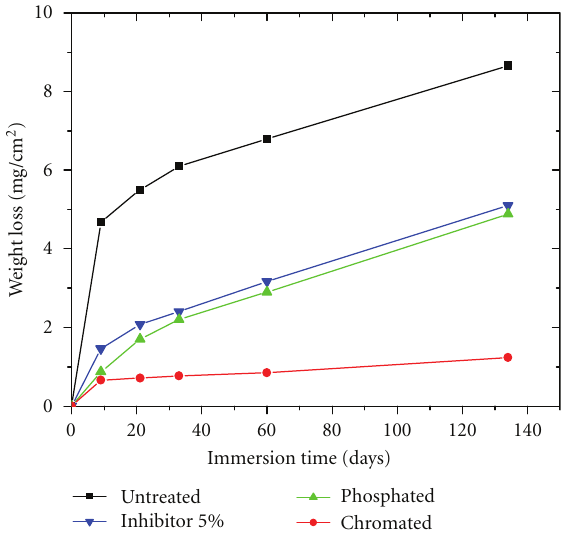
Figure 5: Potentiodynamic polarization curves of galvanized steel with various surface conditions immersed in a 0.5M NaCl solution during